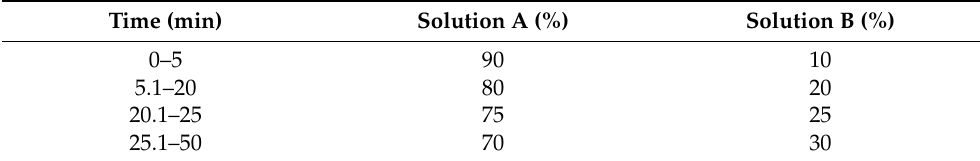
Table 1. RP-HPLC gradient conditions for grape seed